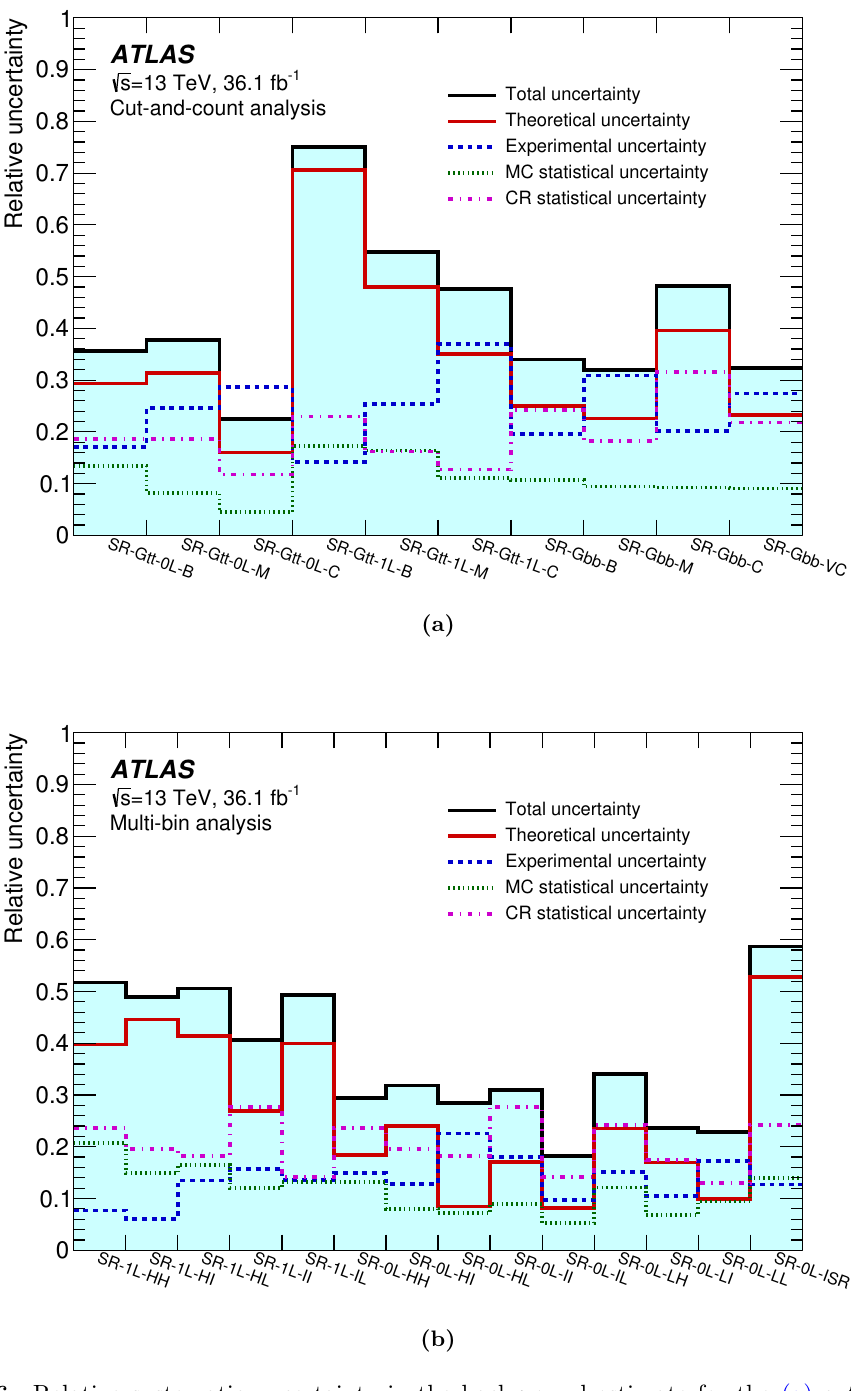
Figure 6. Relative systematic uncertainty in the background estimate for the (a) cut-and-count and (b) multi-bin analyses. The individual uncertainties can be correlated, such that the total background uncertainty is not necessarily their sum in quadrature.